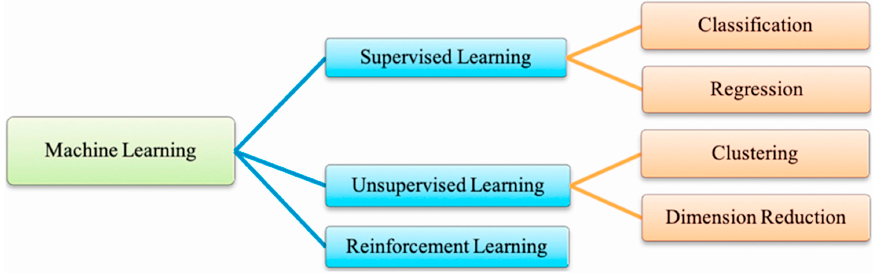
Figure 5. Taxonomy of ML common practices [23].